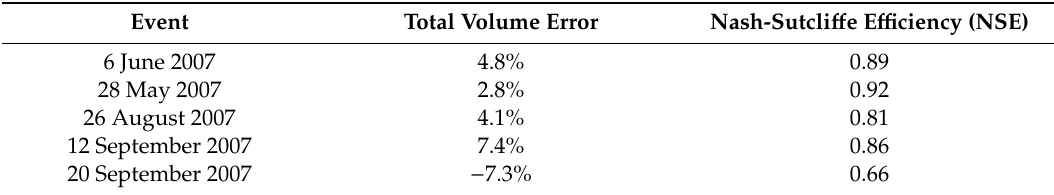
Figure 5. Modeled and observed hydrographs at I5 inlet of storm event on 20 September 2007. Table 4. Model performance in model calibration and validation. The event on 6 June 2007 is the calibration event and all others are validation events.